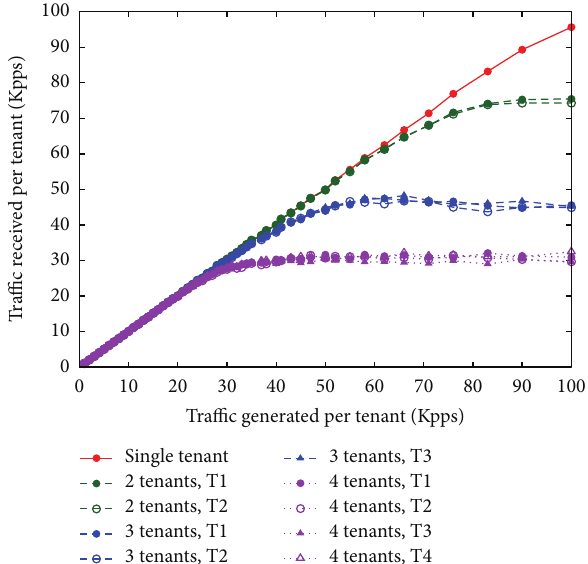
Figure14:Receivedversusgeneratedpacketrateforeachtenant(T1, T2, T3, and T4), for different numbers of active tenants, with 64 -byte IP packet size.